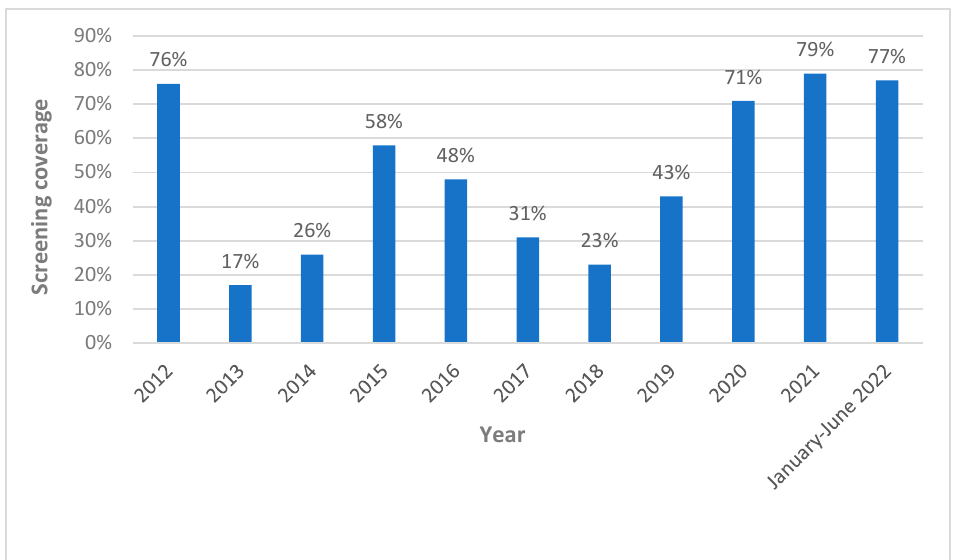
Figure 5. Percentage of Chagas disease screening coverage per year in women at risk who gave birth in Careggi University Hospital.